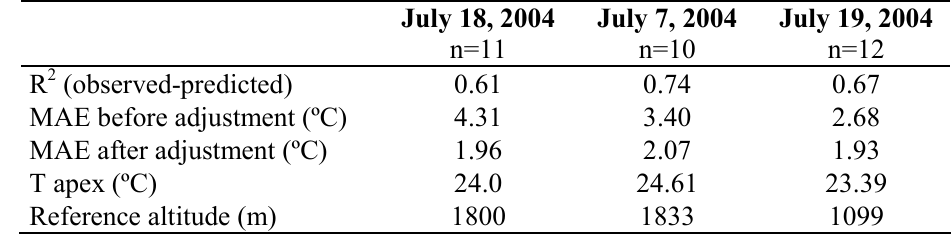
stations. MAE after adjustment is the temperature corrected for a lapse rate of 6.5ºC per 1000 m. Reference altitude is the altitude of the pixels the apex temperature was taken